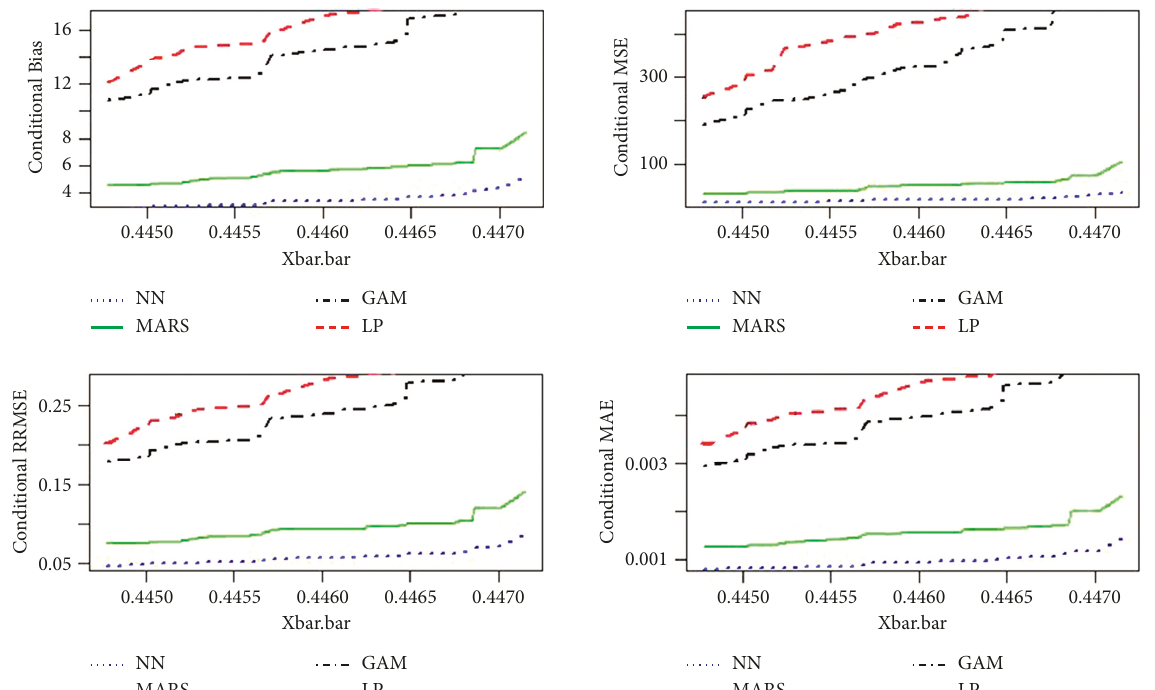
Figure 3: CB, CMSE, CRMSE, and CMAE based on a three-dimensional mixed